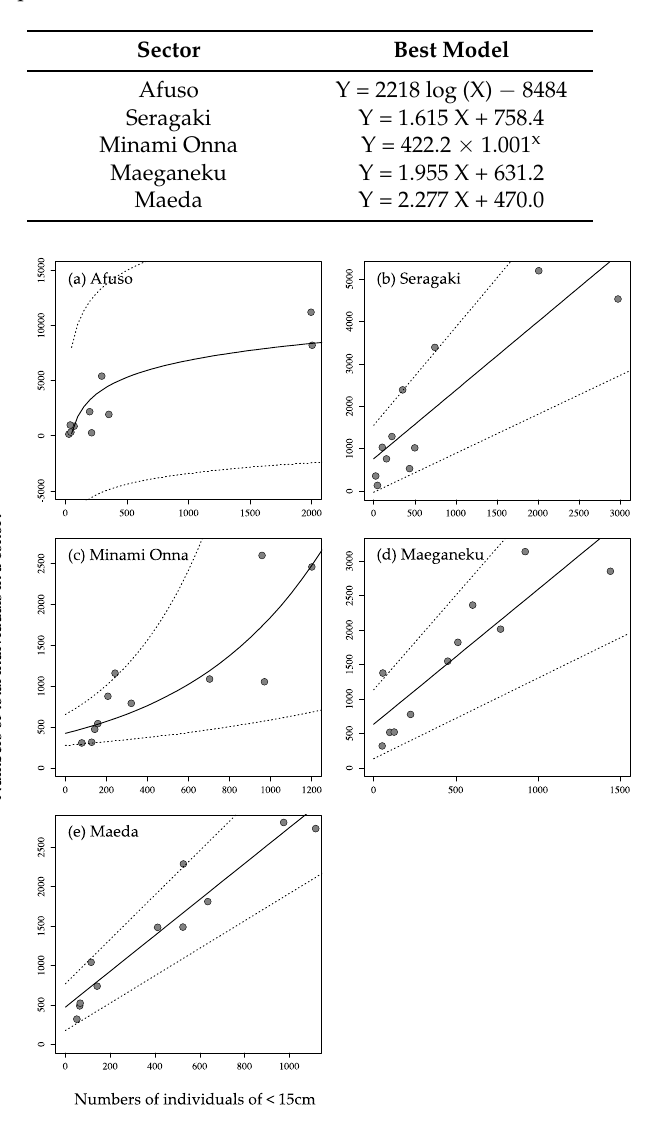
Figure 3. Best-fit model with 95% confidence intervals for the relationship between the numbers of removed individuals <15 cm and the total number of removed individuals in the same cohort of Acanthaster cf. solaris for five sectors along the Onna coast, Okinawa, Japan. ( a ) Afuso; ( b ) Seragaki; ( c ) Minami Onna; ( d ) Maeganeku; ( e )